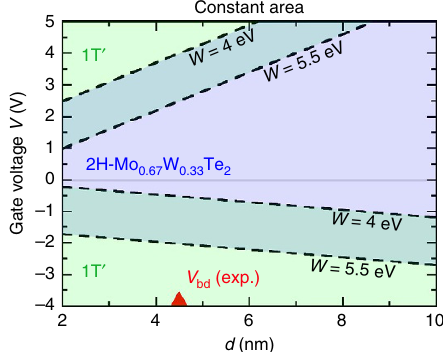
Figure 6 | Reducing transition gate voltages with the alloy Mo x W 1 (cid:2) x Te 2 . Plotted is the phase stability of a representative alloyed monolayer Mo 0.67 W 0.33 Te 2 with respect to the gate voltage V and the dielectric thickness d using the capacitor structure as shown in Fig. 4a. The transition is assumed to occur at constant monolayer area. The magnitudes of the transition gate voltages in this alloy are smaller than those of pure MoTe 2 monolayer indicating the potential for phase boundary